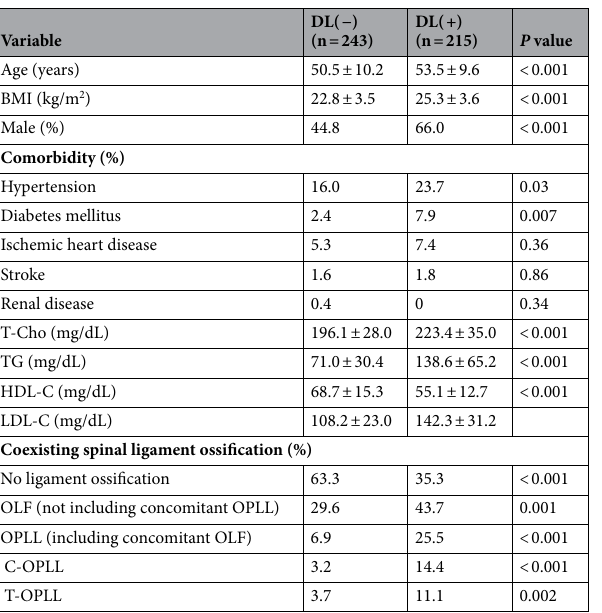
Table 3. Comparison of clinical characteristics between subjects with dyslipidemia (DL[+]) and those without dyslipidemia (DL[−]). Data are shown as mean ± SD or as percentage. DL, dyslipidemia; OPLL, ossification of the posterior longitudinal ligament; OLF, ossification of the ligamentum flavum; BMI, body mass index; T-Cho, total cholesterol; TG, triglycerides; HDL-C, high-density lipoprotein cholesterol; LDL-C, low-density lipoprotein cholesterol; C, cervical; T, thoracic.